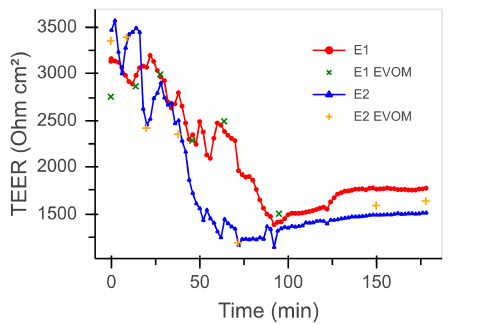
Figure 7. Automatically recorded TEER values for two permeation experiments (E1 and E2) in comparison to values recorded using the